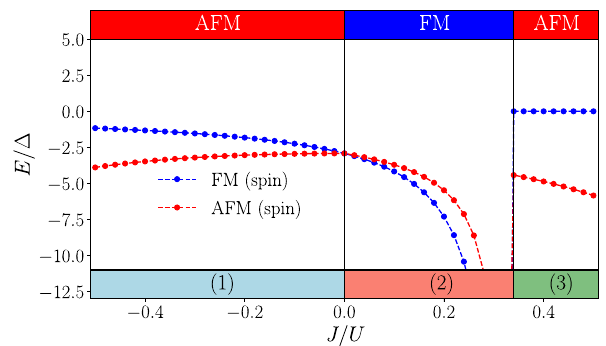
Fig. 5 Magnetic phase diagram of the strong-coupling Hamiltonian (3) in the isotropic limit t σ = t π . Our results from iterative minimization are in agreement with ref. 52 , stabilizing FO nematic order (1) for J / U < 0 (see main text) and FO magnetic order (3) (see main text) for J / U > 1/3. In the intermediate range of parameters 0 < J / U < 1/3 the ferromagnetic spin sector is selected, such that, due to vanishing ξ 0 ij , rotation invariance is restored for the orbital vectors, giving rise to AFM order (2) but without any preferred axis in